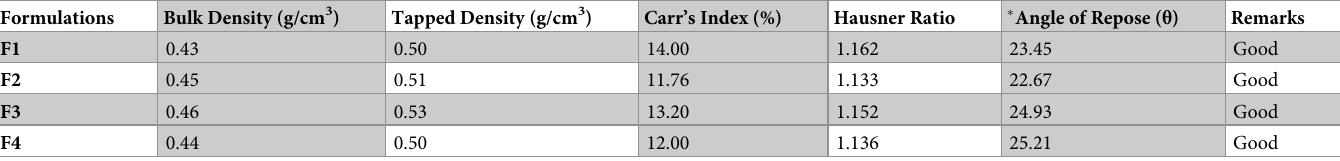
Table 3. Pre-compression parameters of propranolol HCl floating formulations.